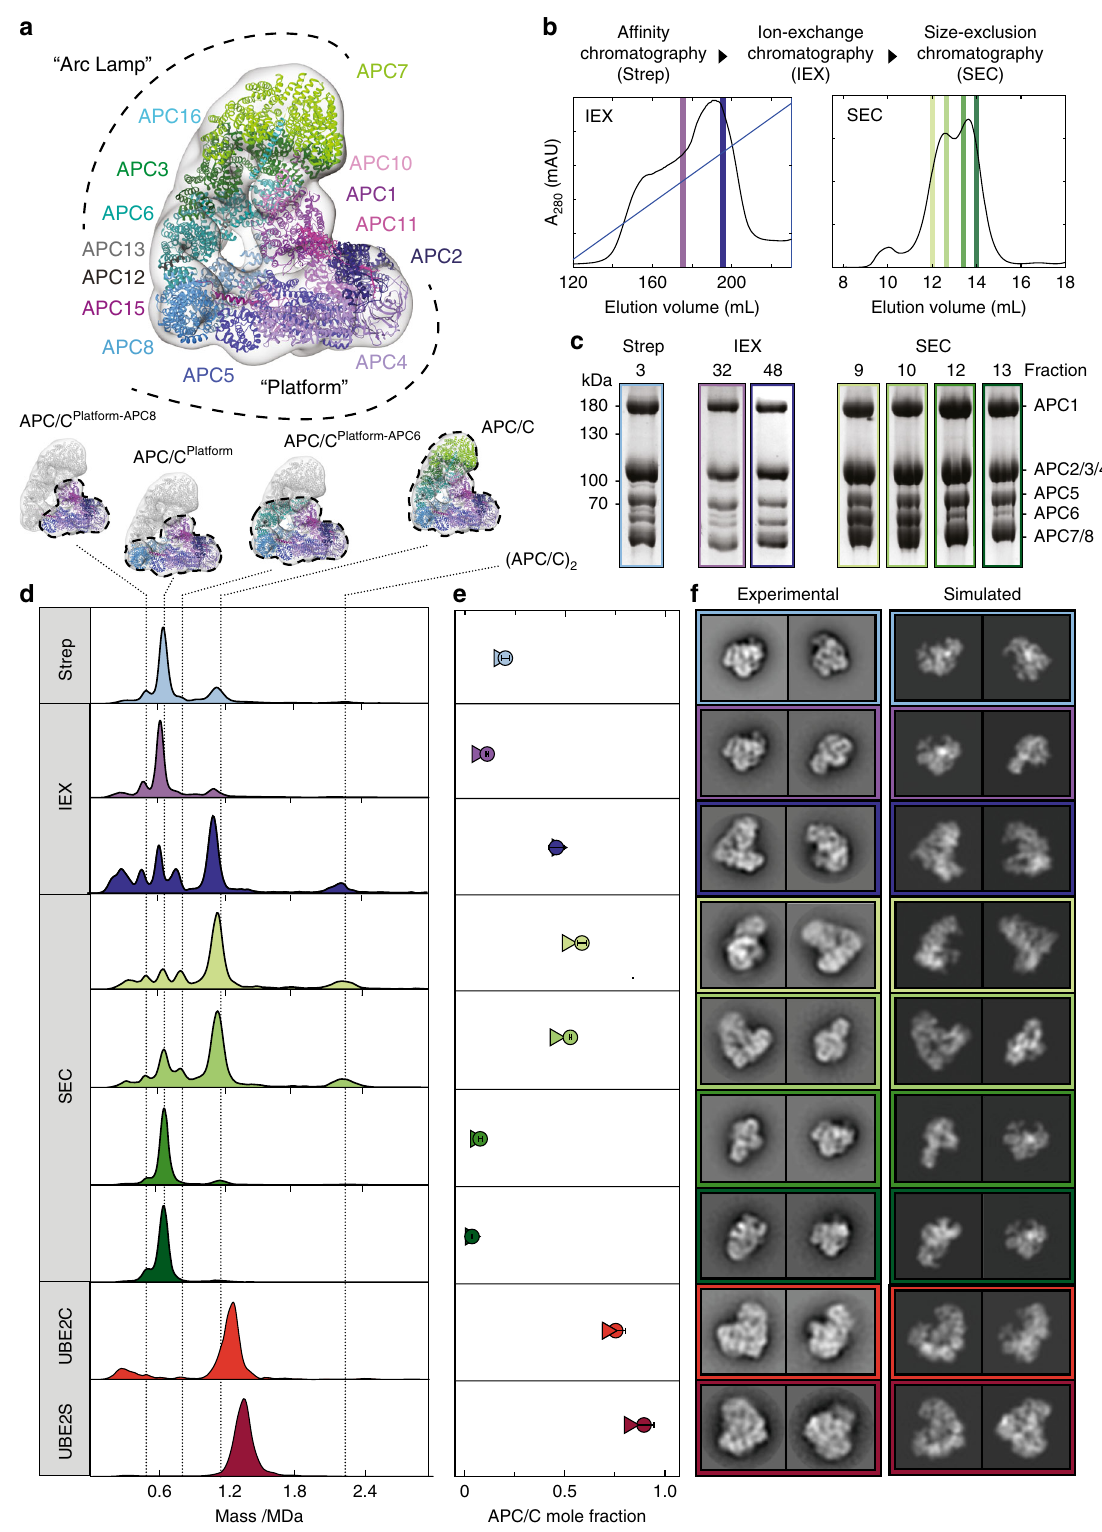
Fig. 2 Quantitative comparison of MP with nsEM for anaphase-promoting complex/cyclosome (APC/C) puri fi cation and crosslinking. a Structural cartoon including highlights of all 14 subunits. b Details of the three-step puri fi cation protocol and fractions analyzed. c SDS-PAGE gels of all fractions highlighted in b . d Corresponding mass distributions of puri fi cation step fractions and APC/C CDH1 -UBE2C and APC/C CDH1 -UBE2S traps indicated as UBE2C and UBE2S, respectively. e Comparison of assembled fractions obtained by MP (circle) and nsEM (triangle). For the evaluation of mole fractions, we did not consider species below 400kDa to avoid errors from buffer background for the trap samples. Error bars are calculated as the standard deviation of mole fractions from different repeats. f 2D class averages of the two most populated classes obtained by each step are shown along with simulated projections of either APC/C or APC/C Platform . Source data are provided as a Source Data fi